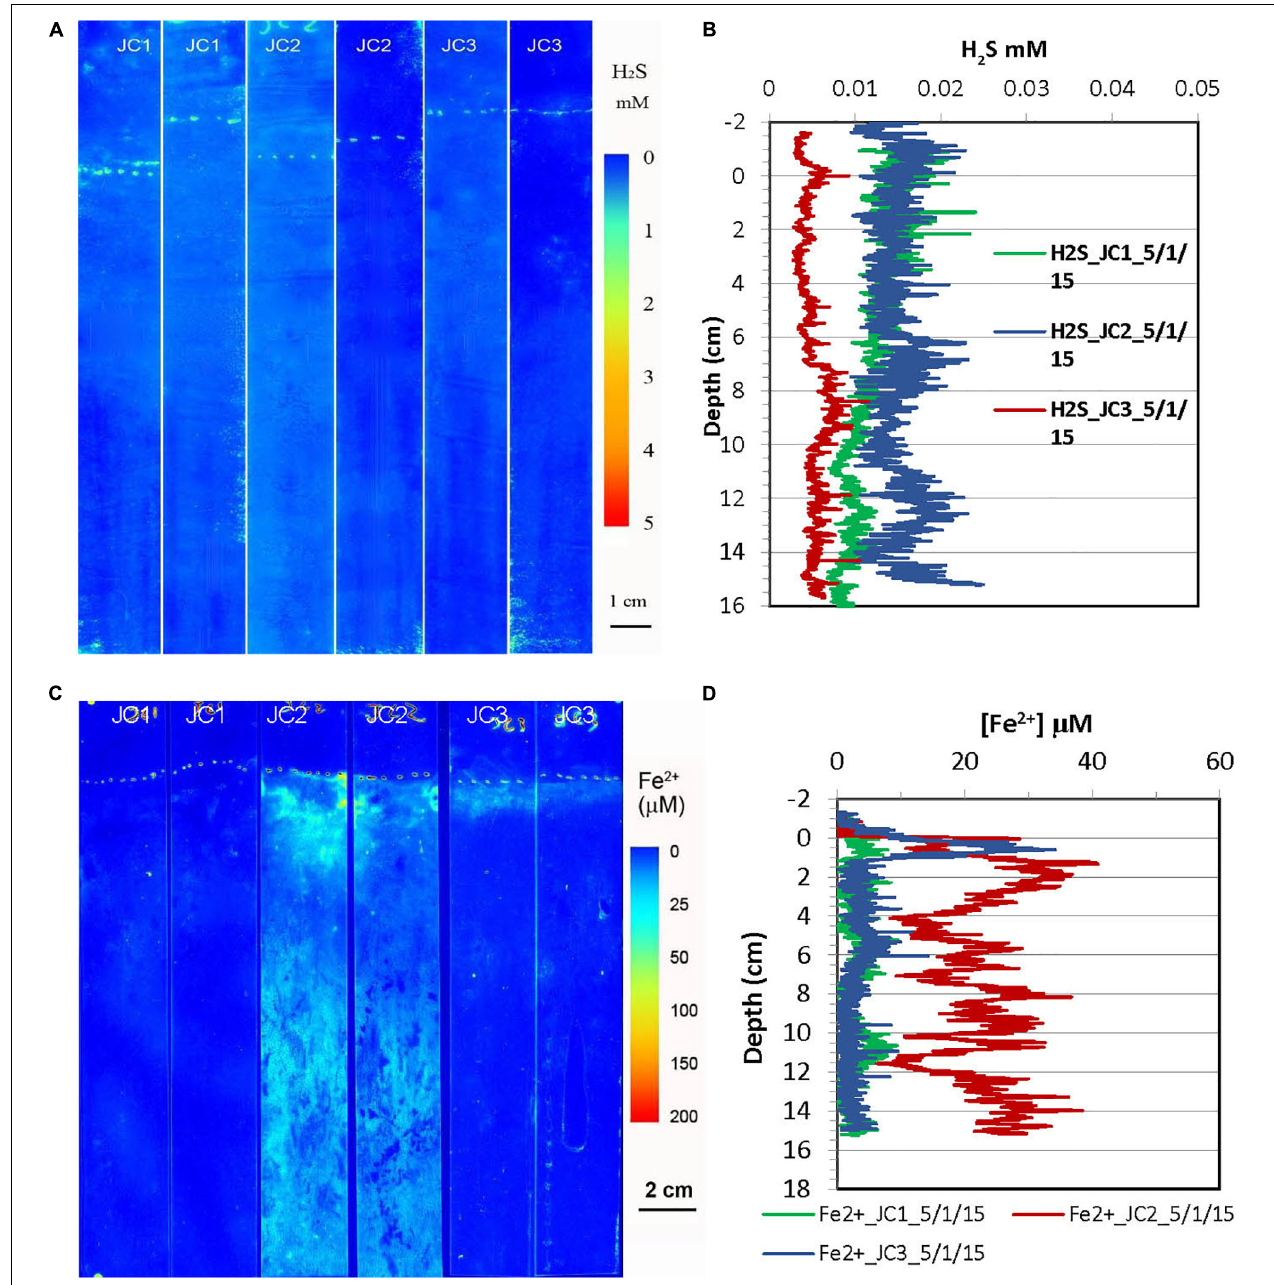
FIGURE 5 | H 2 S and dissolved Fe 2 + distribution patterns in the pore water of JoCo (JC) marsh peats in spring 2015. (A) 2-D H 2 S distribution patterns (pseudo color) obtained by in situ measurements in sediments; white line marks the peat surface. (B) Vertical H 2 S profiles averaged from each 2-D H 2 S distribution in the panel (A) . (C) 2-D Fe 2 + distribution patterns obtained by in situ deployments; white line marks the peat surface. (D) Vertical Fe 2 + profiles averaged from each 2-D Fe 2 + distributions in the panel (C)